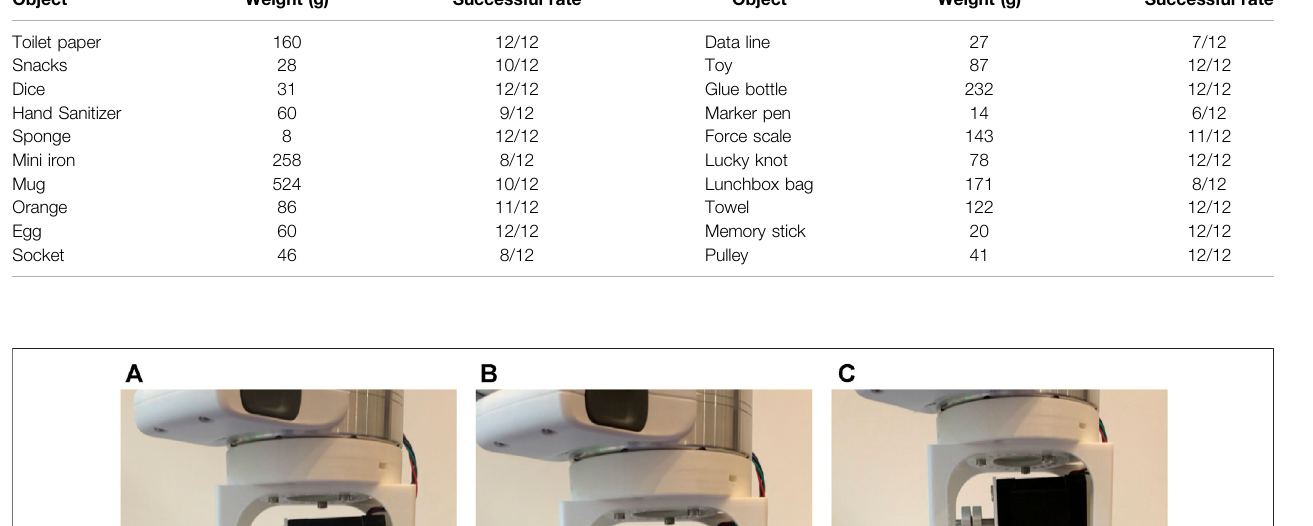
Frontiers in Robotics and AI |